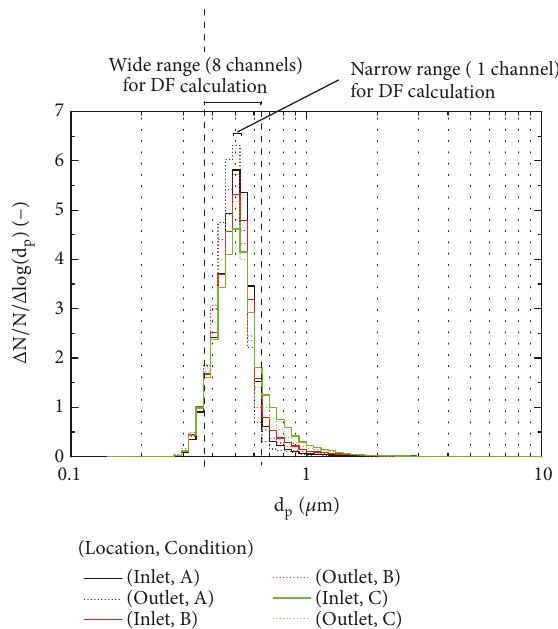
Figure 2: Particle diameter distributions of test particle measured by